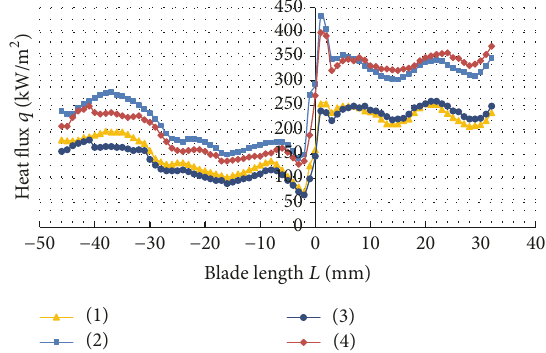
Figure 11: Distribution of heat flux along the surface of section 3: (1, 3) 𝑃 𝑏 /𝑃 0 = 1.48; (2, 4) 𝑃 𝑏 /𝑃 0 = 1.97; (1, 2) 𝑞 𝑧 ; (3, 4) 𝑞 𝑐